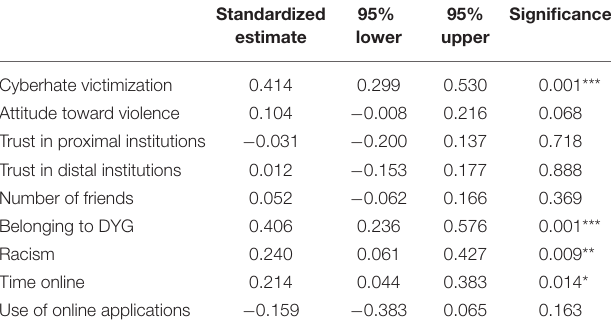
TABLE 5 | Regression coefficients on latent factor “cyberhate